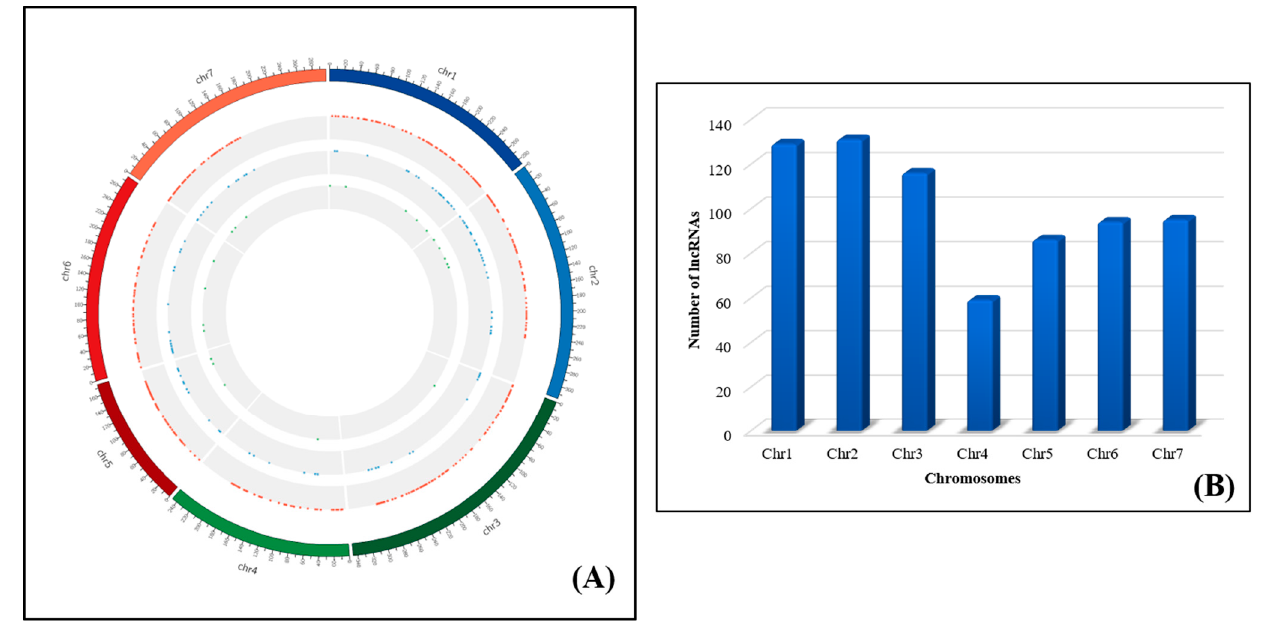
Figure 3. ( A ) Chromosome-wise distribution of lncRNAs in pearl millet. Red dots represent intergenic lncRNA, blue dots as intronic lncRNA and green dots as exonic overlap on the opposite strand lncRNA ( B ) Graphical representation of distribution of lncRNAs over the pearl millet chromosomes on the opposite strand lncRNA.